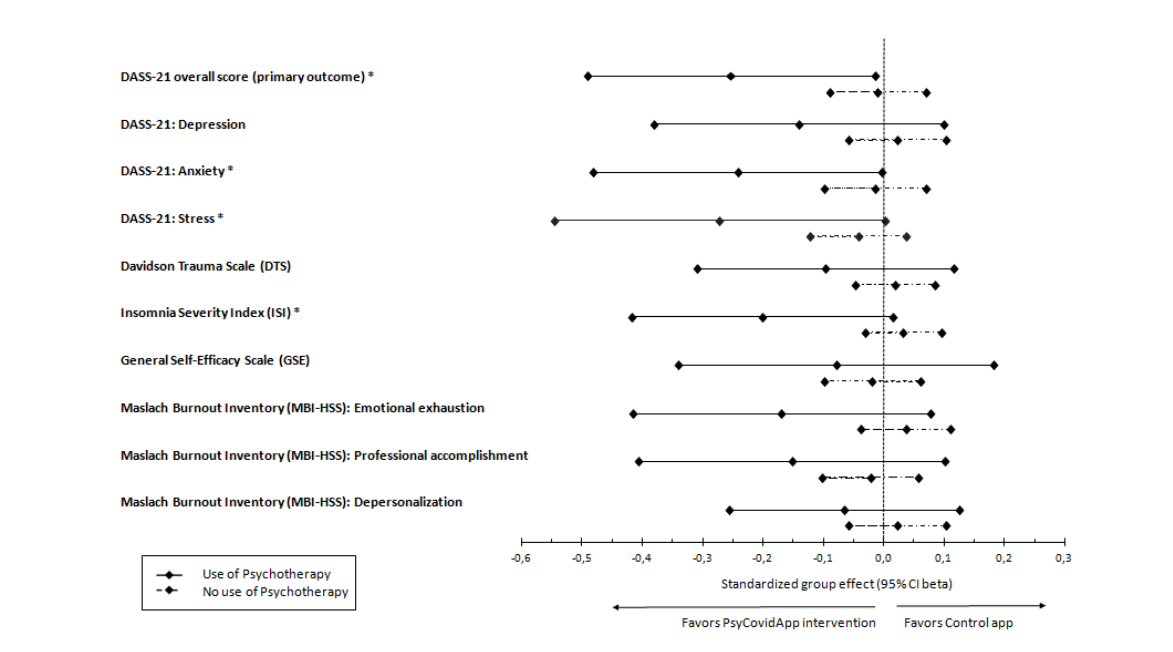
12.65). After the trial, 208 of the 221 participants in the intervention group (94.1%) asked the research team if they could regain access to the PsyCovidApp